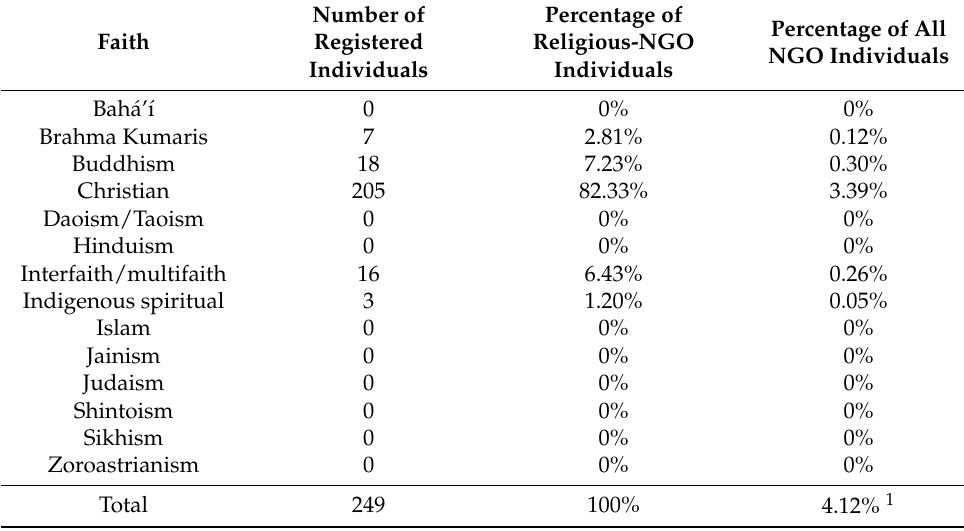
Table 3. Individuals representing religious NGOs at COP 24.